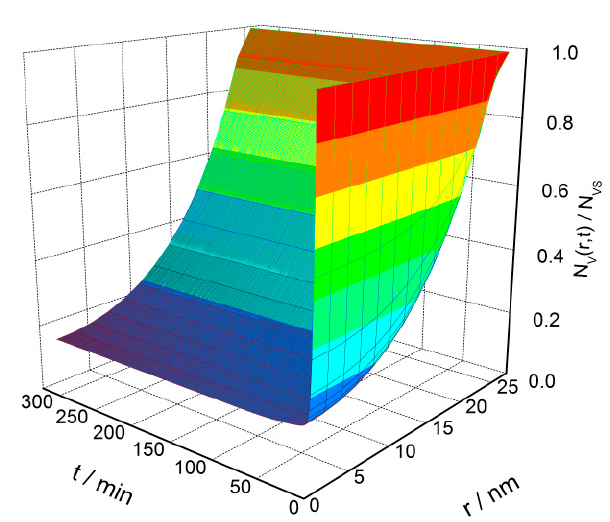
Figure 7. Time-dependent oxygen vacancy distribution in a 25 nm semiconductor grain from the initial uniform distribution to a steady state gradient distribution.